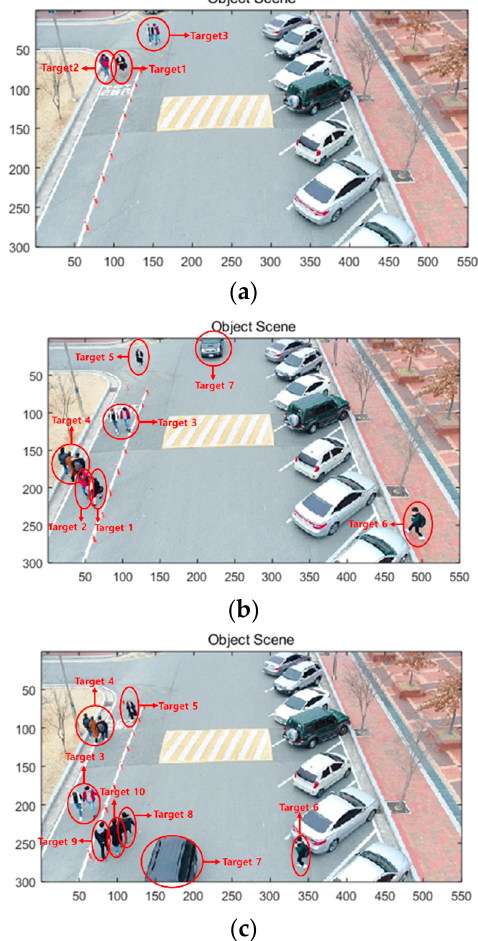
Figure 8. ( a ) Targets 1–3 in the sixth frame, ( b ) Targets 1–7 in the 350th frame, ( c ) Targets 3–10 in the 550th frame. Table 1. Target characteristics.